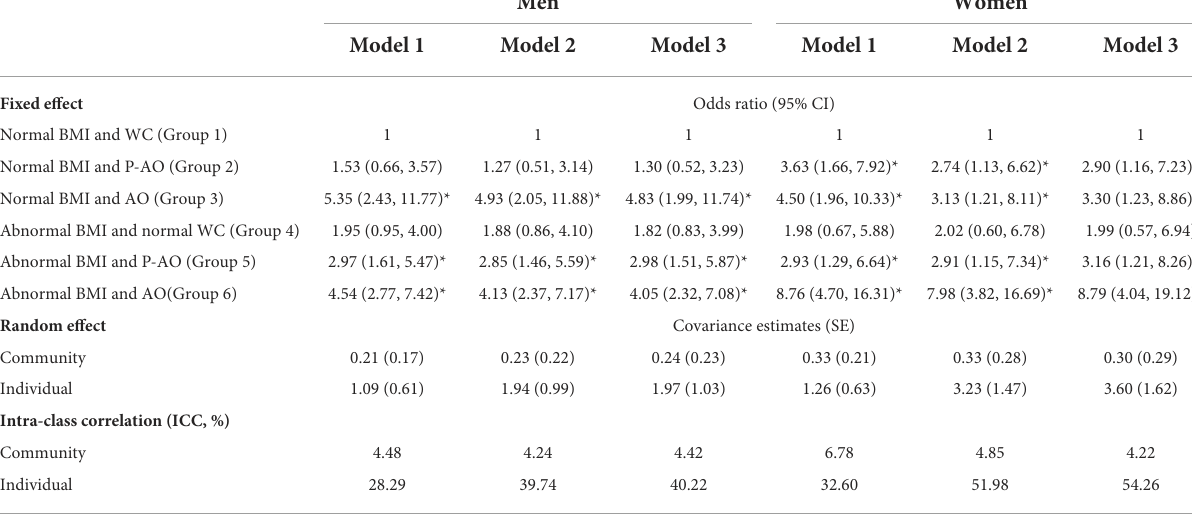
TABLE 4 Association between combined obesity and risk of type 2 diabetes among Chinese adults aged 18–65, in three-level mixed-effects logistic regression †